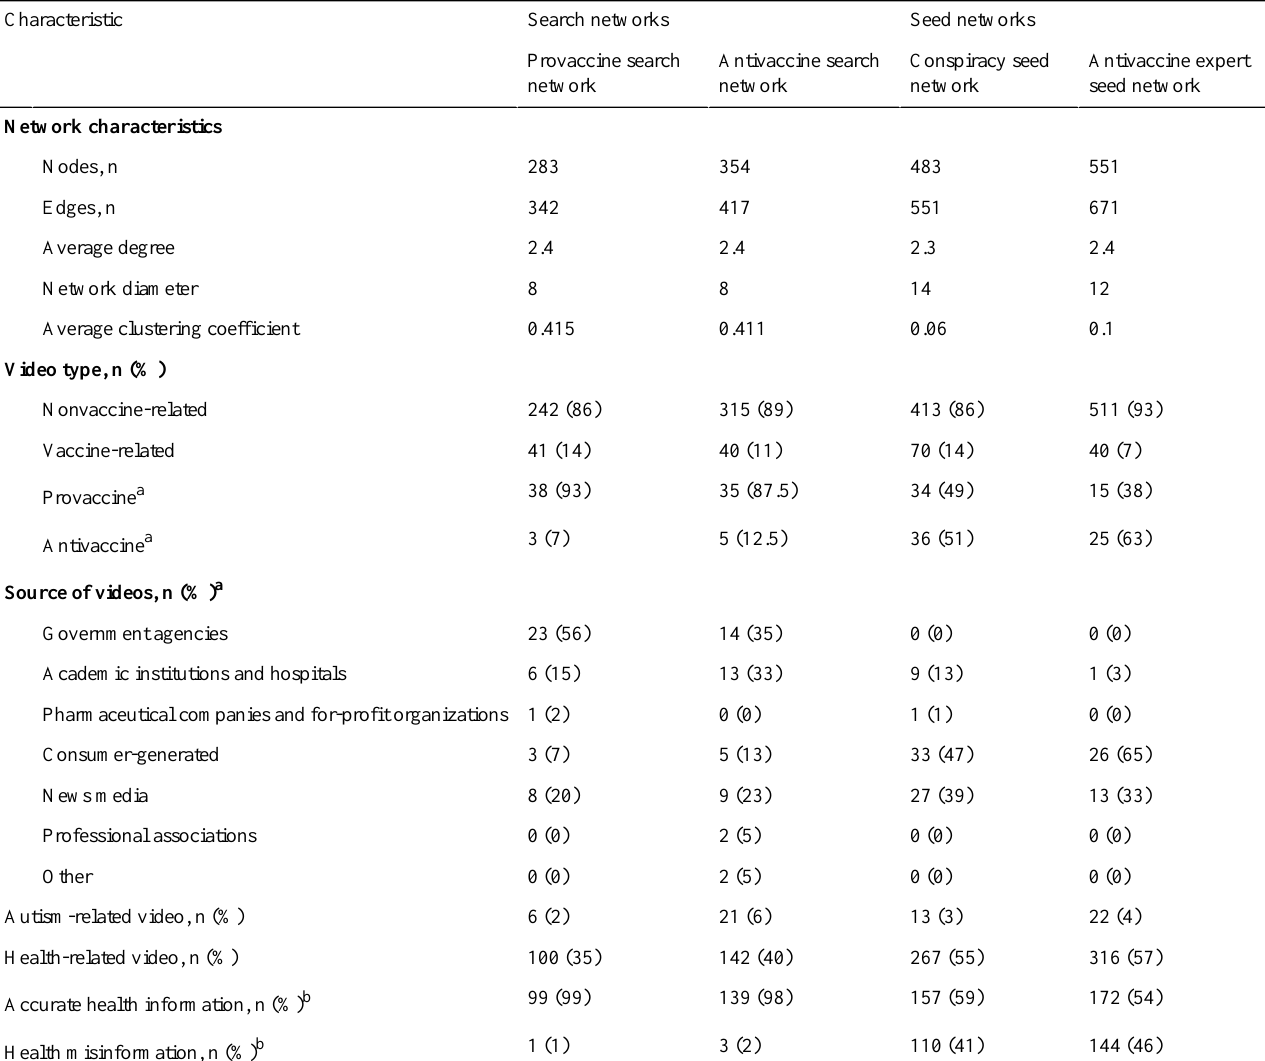
Table 1. Global statistics for the four collected